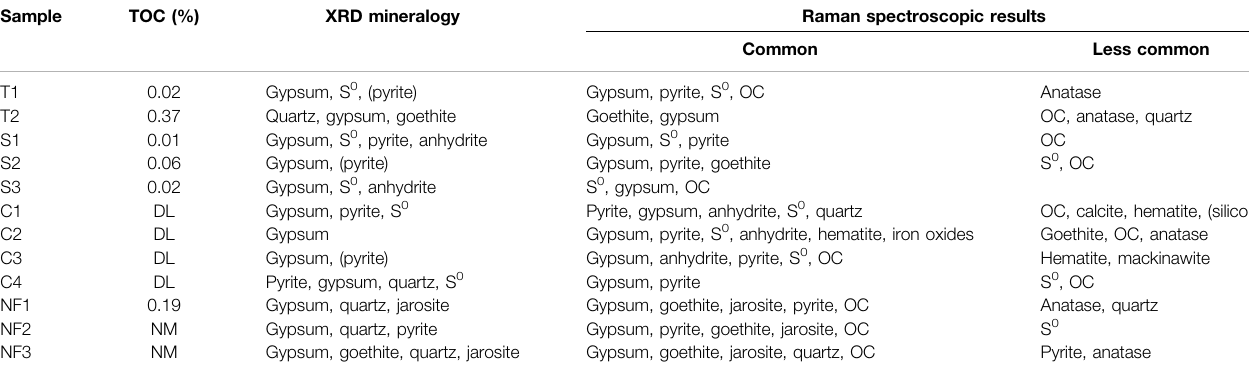
ForTOCmeasurements, “ DL ” indicatesbelowdetectionleveloftheinstrument(seetext),while “ NM ” indicateswherenomeasurementwascollected.XRDdataareorderedbydominant peak heights; questionable mineral assignments are indicated in parentheses. Raman spectroscopic results are split into the most common and less common phases observed (most commonareobservedinnearlyeveryobservedregionofthesamplematerial,whilelesscommonphasesaresparselylocatedwithinthematerials).S 0 indicateselementalsulfur,whileOC indicates organic carbon.